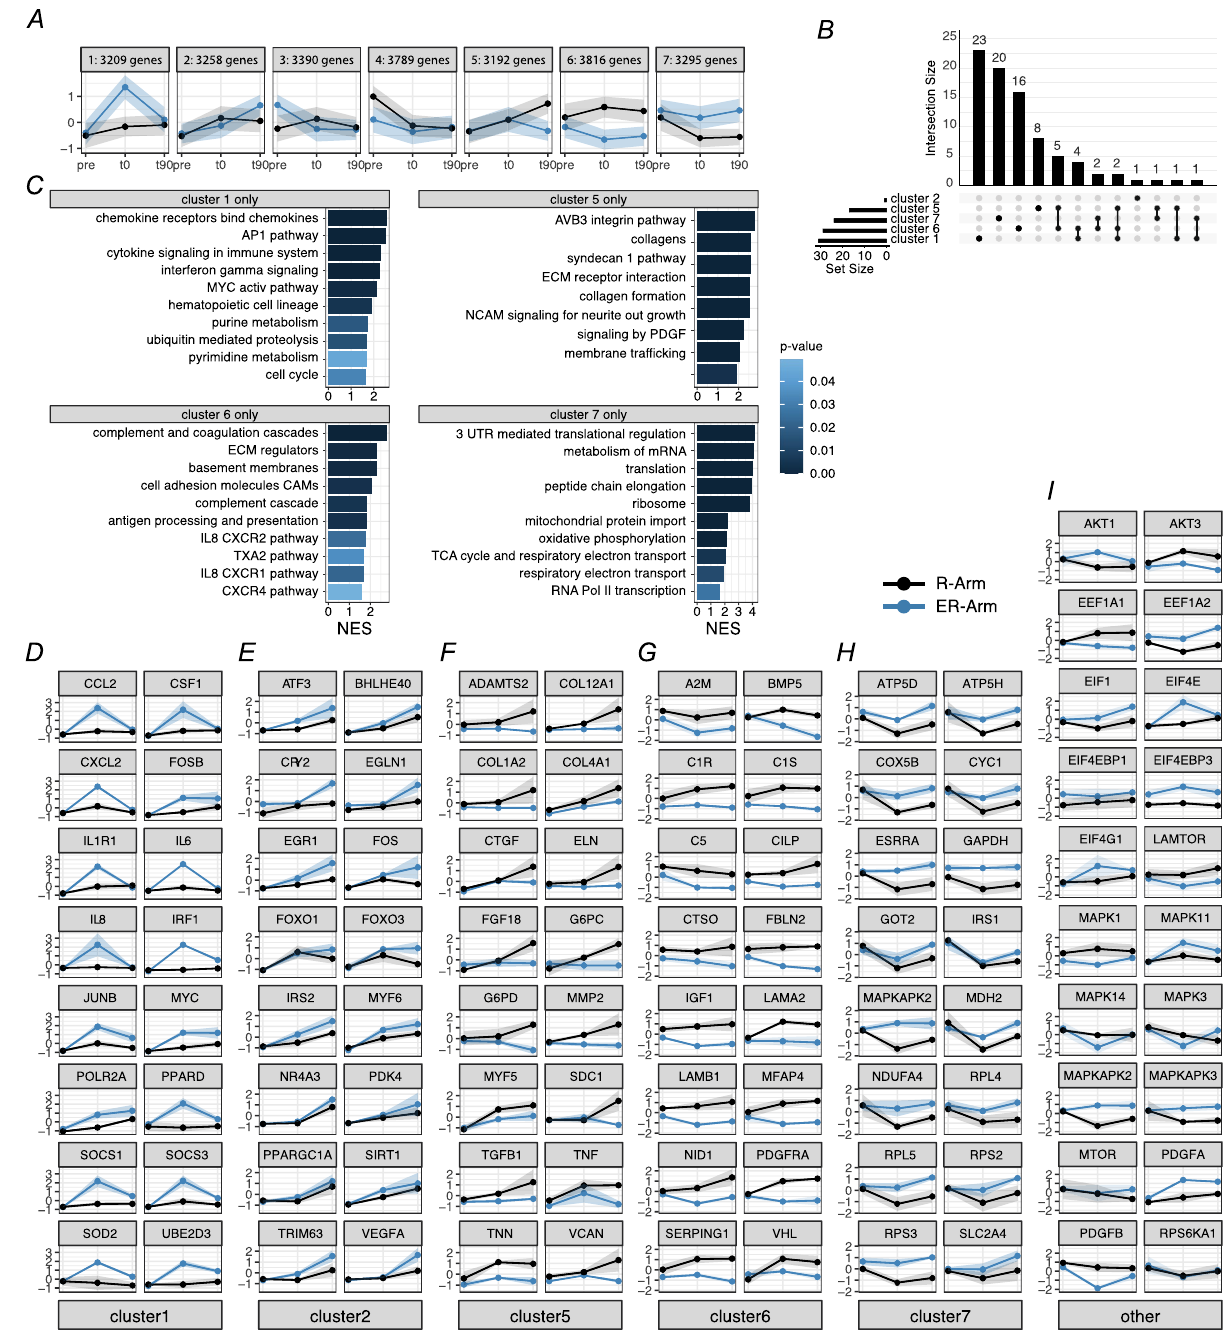
Figure 7. Clustering of gene expression for R-Arm (black lines) and ER-Arm (blue lines) RNASeq at different time points (0 min, 90 min). K-means clustering based on gene expression and fold-changed in individual time points identified 7 cluster with distinct expression profiles ( A ). Pathway analysis of individual clusters by GSEA, with genes ranked by fold-change/standard deviation ratio identified both distinct and common pathways, shown as upset-plot ( B ). Pathways exclusive to individual clusters with their respective normalized enrichment score (NES) are plotted with their p-value indicated by color ( C ). Only single pathway (Smad2/3 nuclear signaling) has been identified for cluster 2 and is not shown. Expression profiles of selected genes for individual clusters ( D – H ). Expression profiles of selected genes that either play role in protein synthesis or show interesting complementary expression patterns ( I